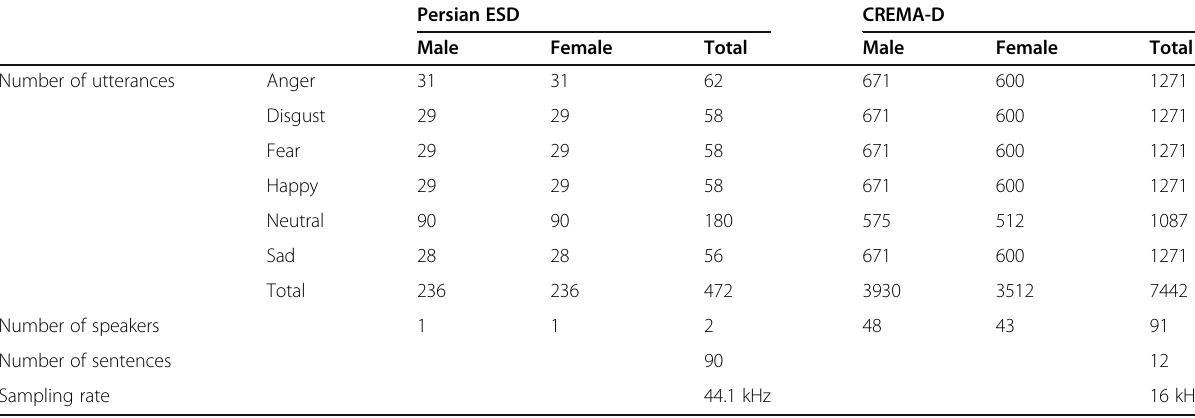
Table 1 The specifications of the Persian ESD and CREMA-D databases Persian ESD